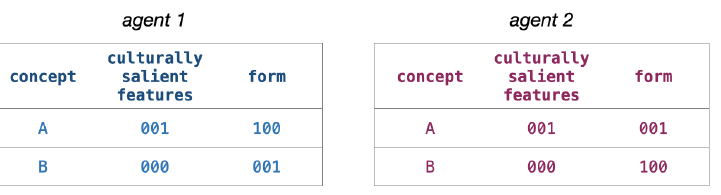
Figure 6. Example agents for calculating the mean degree of iconicity and the mean lexical